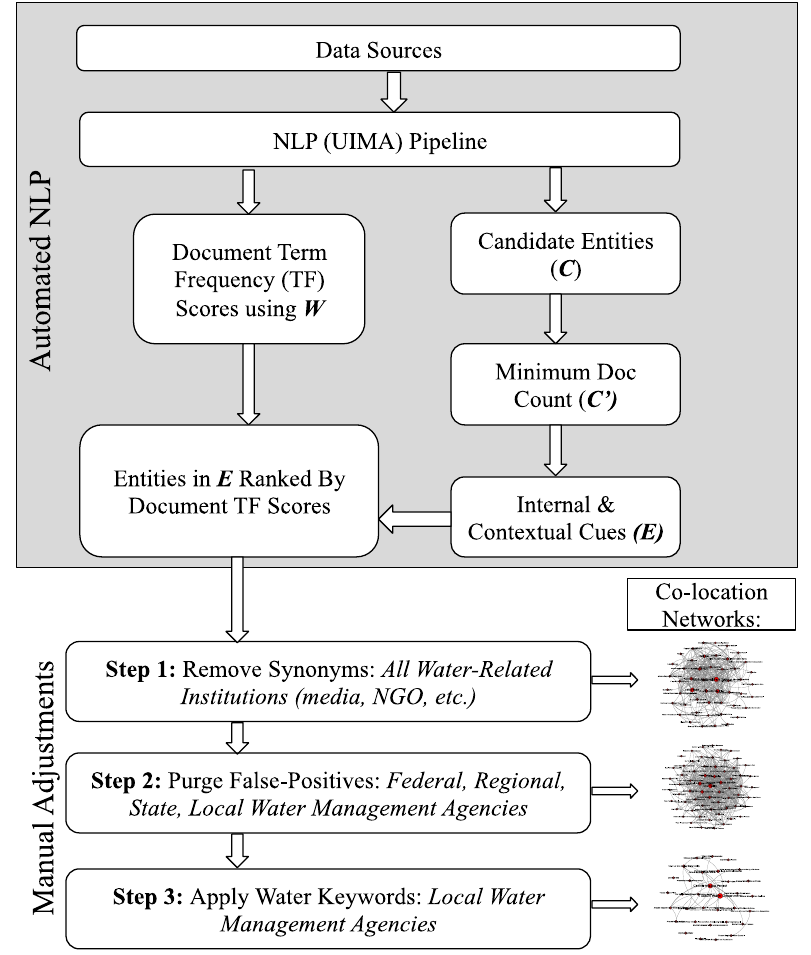
Figure 2. Analysis workflow diagram. NLP, natural language processing; UIMA, Unstructured Information Management